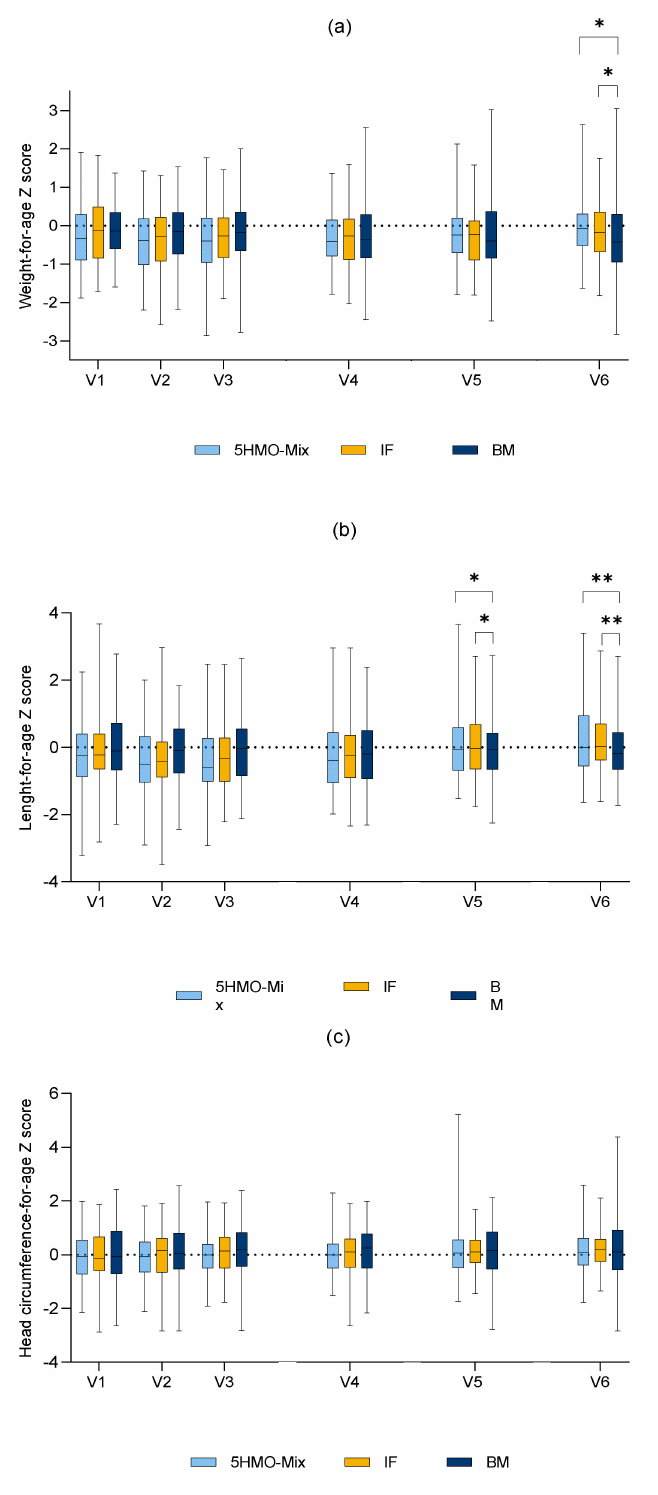
Figure 3. WHO growth standard z-scores weight-for-age ( a ), length-for-age ( b ), and head circumference-for-age ( c ) per visit. Full analysis set. Explorative p -values: * p < 0.05, ** p < 0.01. Abbreviations: 5HMO-Mix = 5HMO-Mix in infant formula, IF = infant formula without 5HMO-Mix, BM = breastfed